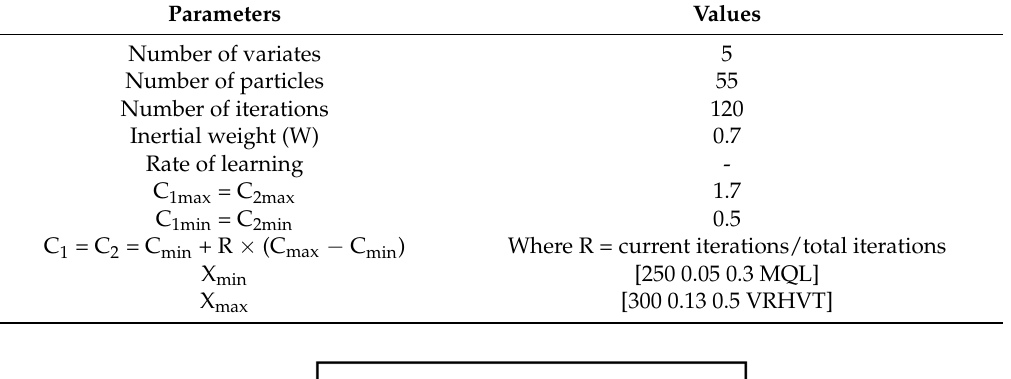
Table 5. Particle swarm optimization (PSO) parameters.